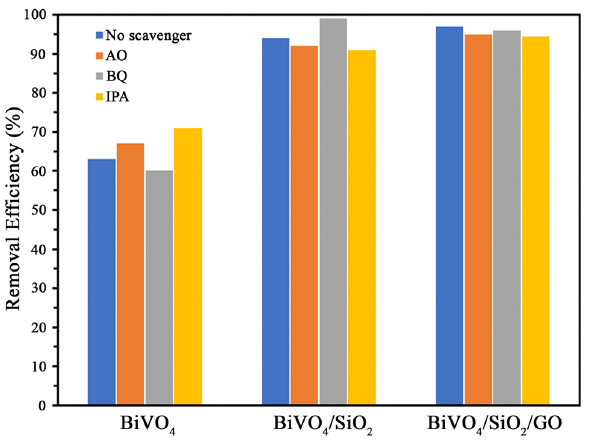
Figure 8. Effect of scavenger on the photodegradation of MB over BiVO 4 , BiVO 4 /SiO 2 and BiVO 4 /SiO 2